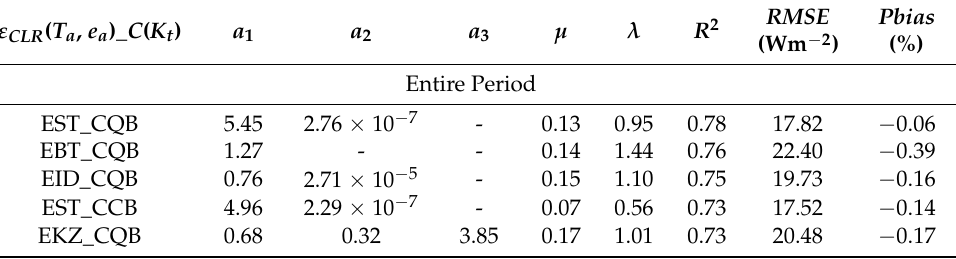
Table 5. Calibrated coefficients and the statistical index for the entire period and different sky coverage classifications for the five best results in Step